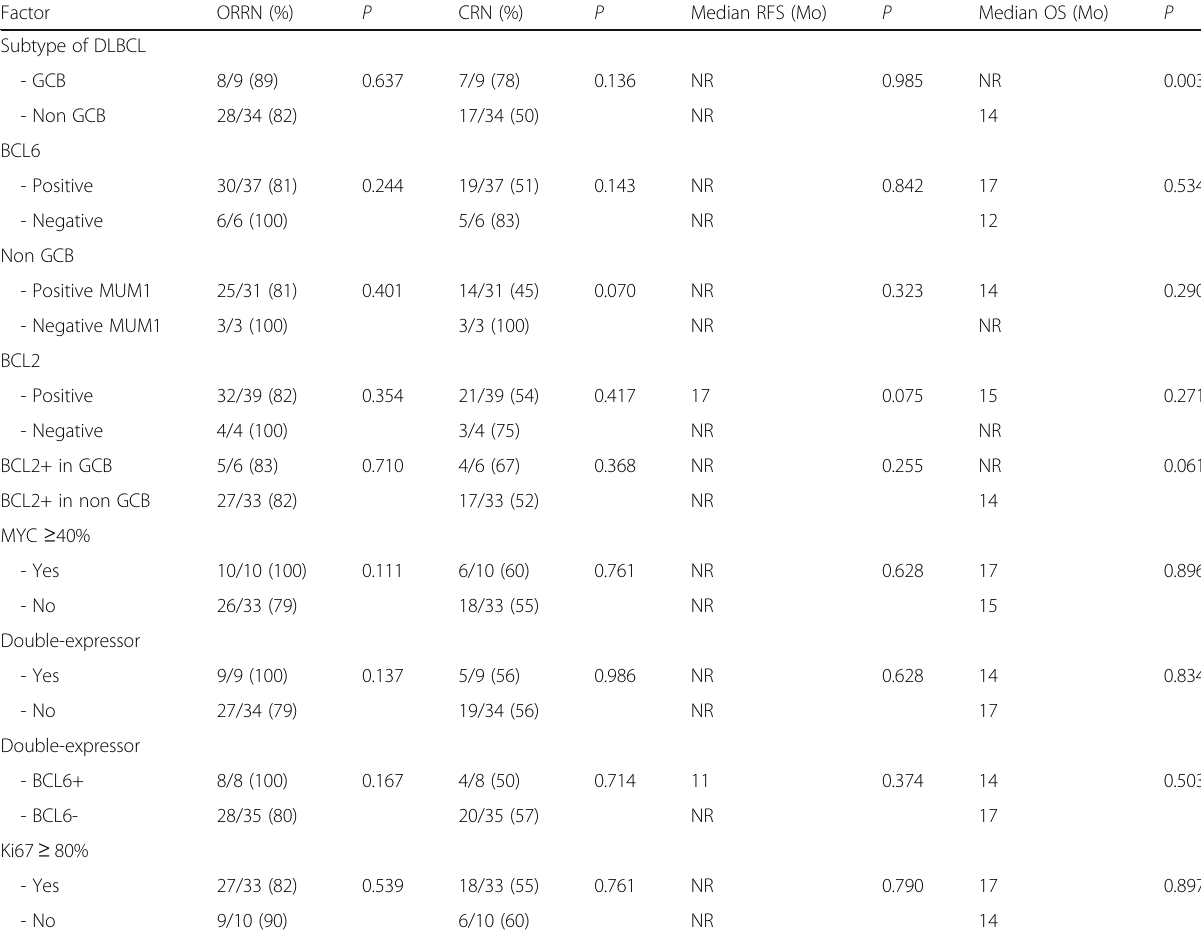
Table 2 The immuno-histochemical findings and treatment outcomes in 43 adult patients with PCNSL